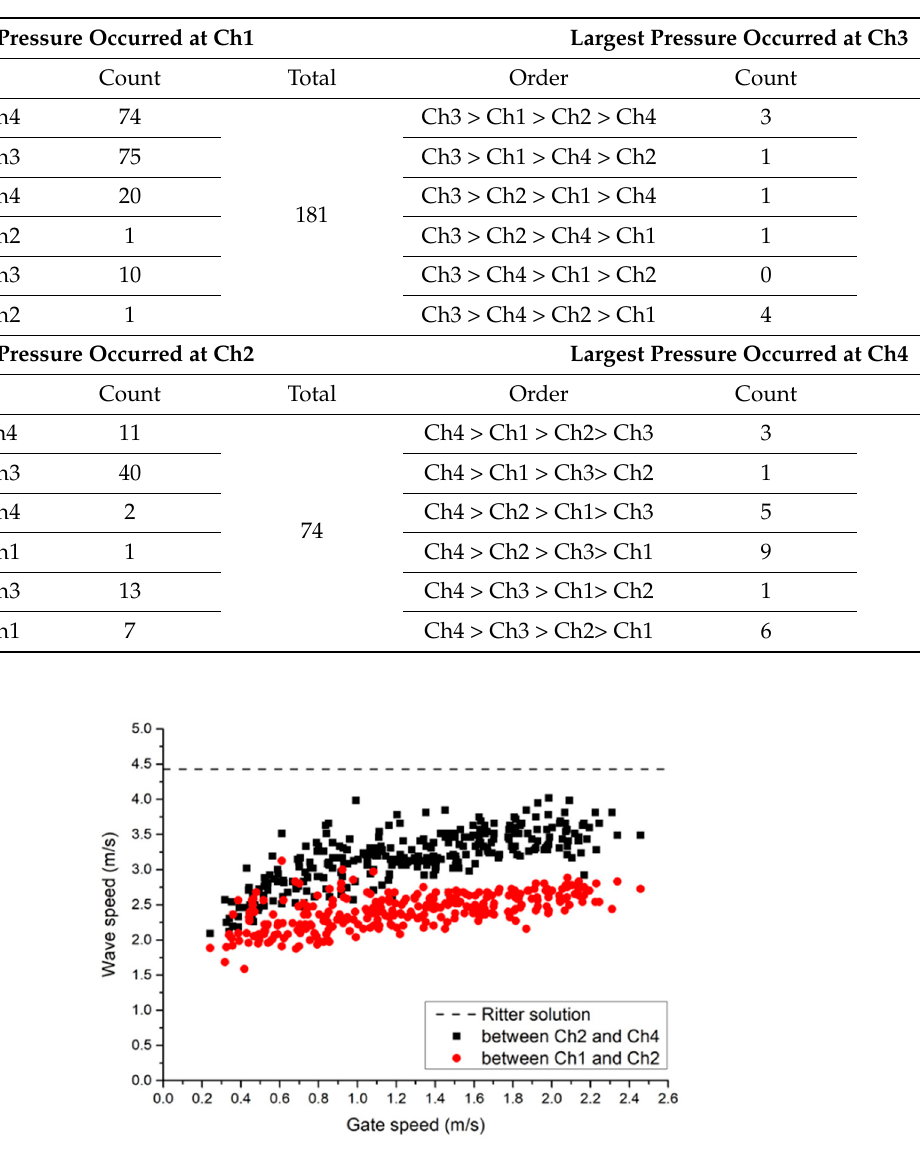
Table 1. Number of cases for each pressure sensor that recorded the largest pressure.